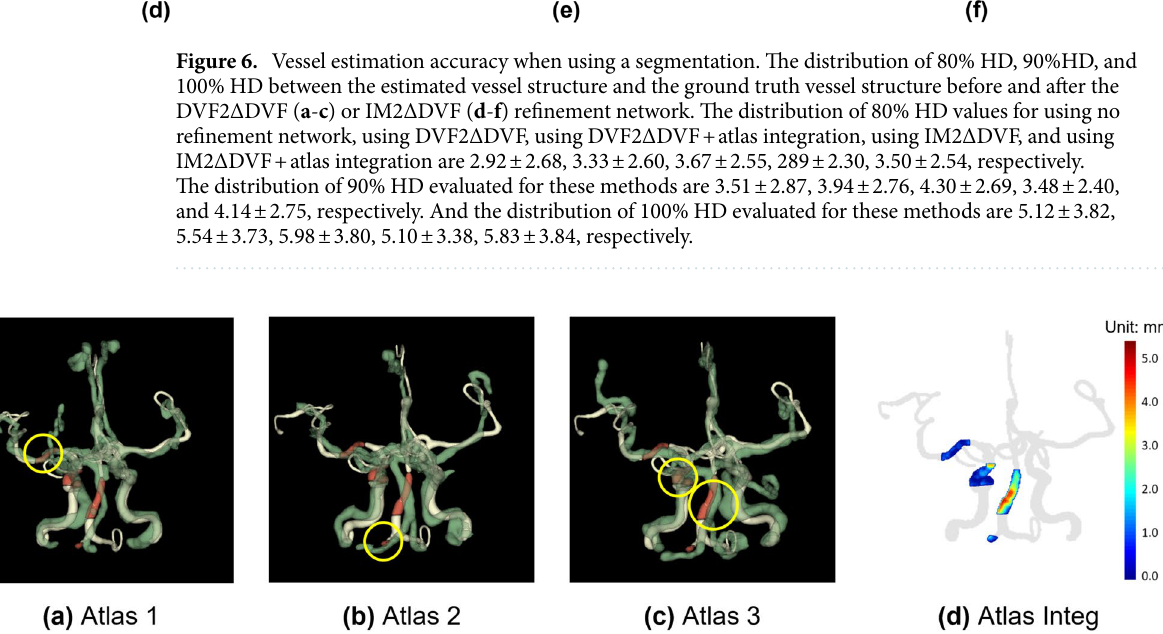
Figure 7. An example case illustrating atlas integration. The target vessel structure (white), with four clinically significant vessel segments (red), is overlapped with top three estimated vessel structures from atlas (green). The yellow circles highlight the chosen segment estimate(s) from each atlas. In this specific example, ( a ) the right middle cerebral artery (RMCA) was obtained from atlas 1, ( b ) the right vertebral artery (RVA) was obtained from atlas 2, and ( c ) the right internal carotid artery (RICA) and basilar artery (BA) were obtained from atlas 3. ( d ) The resulted vessel information has smaller than 5 mm deviation from the ground truth vessel on all